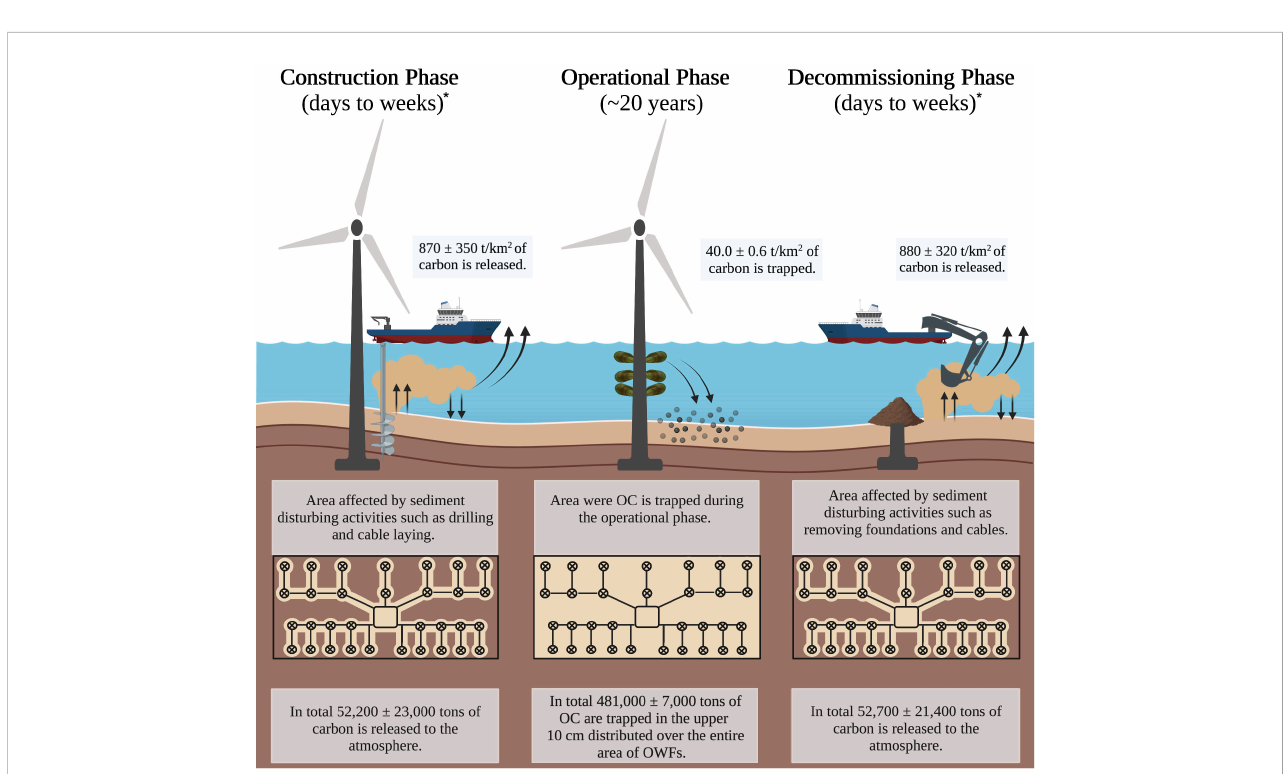
FIGURE 3 Impacts of different life cycles (construction phase, operational phase, decommissioning phase) of OWFs on the sediment and the resulting trapped and released organic carbon (OC) in the upper 1 m of the sediment. The area affected during the different life cycles is highlighted (light brown). The absolute values apply to the entire area of the OWFs in the Southern North Sea (SNS). For the construction and decommissioning phases, we round the values to one fi gure after the fi rst signi fi cant fi gure to illustrate their minor differences.*The period refers only to the duration of sediment-disturbing activities of individual elements of OWFs, such as individual cables and individual turbines, and not to time needed to install the entire wind farm or to the duration of all processes involved in construction or decommissioning, i.e. the time for installation of the rotor blades is not considered, for example.